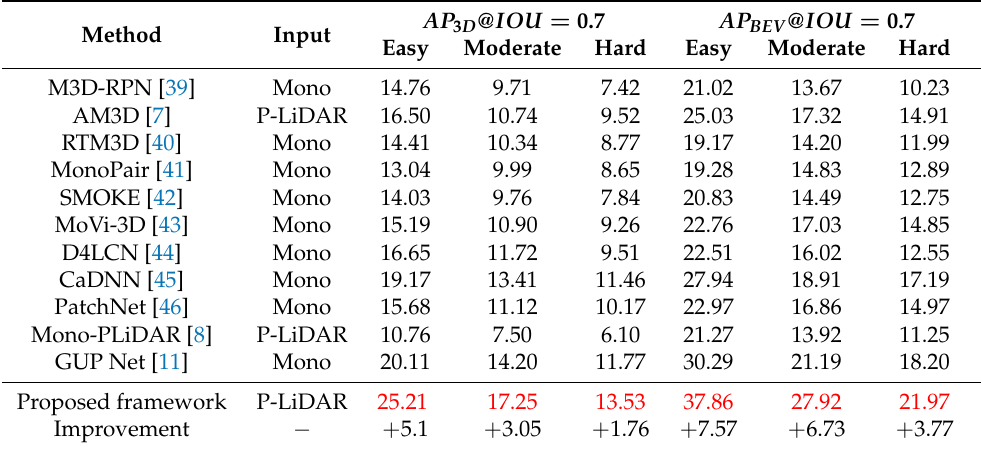
Table 1. Performance of 3D detection of the "car" category on the KITTI test set. We indicate the highest results with red.